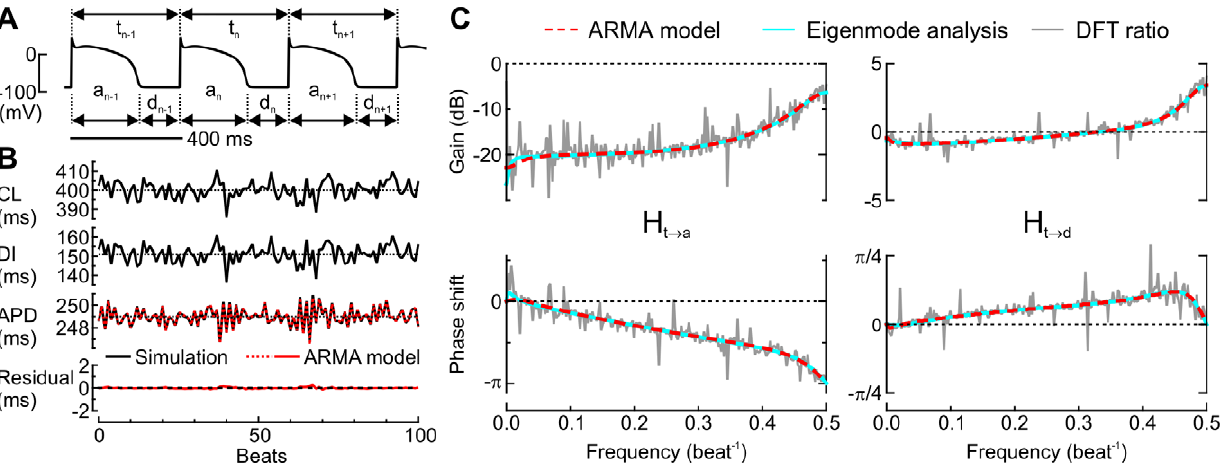
Figure 3. Example analysis in the Ca 2 + -driven model with positive Ca 2 + to APD coupling. The model was paced at cycle lengths (CLs) varying randomly around 400 ms with a SD of 5 ms. A : Example APs, together with the convention regarding the numeration of CLs (t), APDs (a) and DIs (d). B : CLs, DIs, APDs during 100 consecutive beats, estimation of APD based on a 3 rd order ARMA model (Eq. 18), and residual. The identified coefficients were: a 1 = 2 0.2329, a 2 = 2 0.7401, a 3 =0.0395, and b 1 =0.1351, b 2 = 2 0.1058, b 3 = 2 0.0293. The poles of the ARMA model were p 1 = 2 0.780, p 2 =0.053, p 3 =0.961. C : Comparison of the transfer functions H t R a and H t R d (gain and phase shift) derived using eigenmode analysis, computed from the ARMA model coefficients and obtained directly from ratios of discrete Fourier transforms (DFTs, on 512 consecutive cycles), respectively.